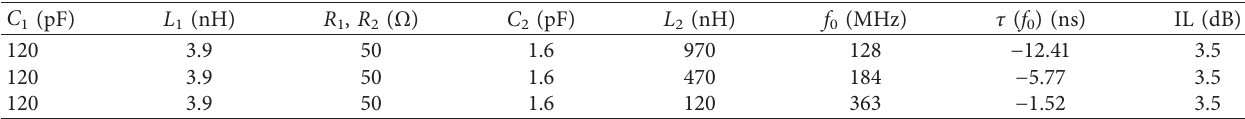
1 values when band-pass negative group delay